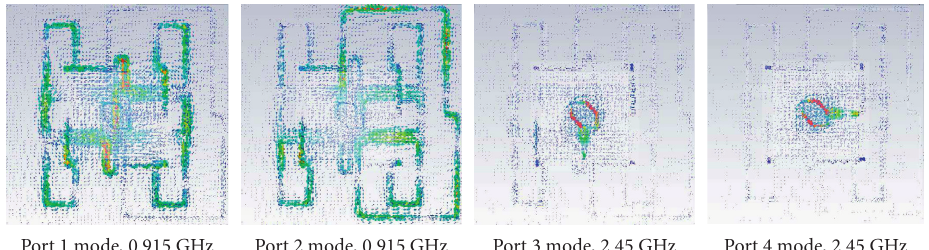
Figure 6: Surface current at Ports 1–4 modes: (a) Port 1 mode, 0.915GHz, (b) Port 2 mode, 0.915GHz, (c) Port 3 mode, 2.45GHz, and (d) Port 4 mode, 2.45GHz.